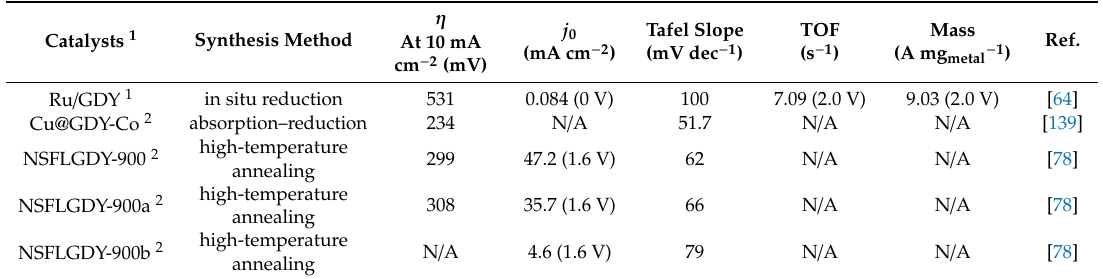
Table 3. OER performance of metal-atom-anchored GDY and nonmetallic-atom-doped GDY.